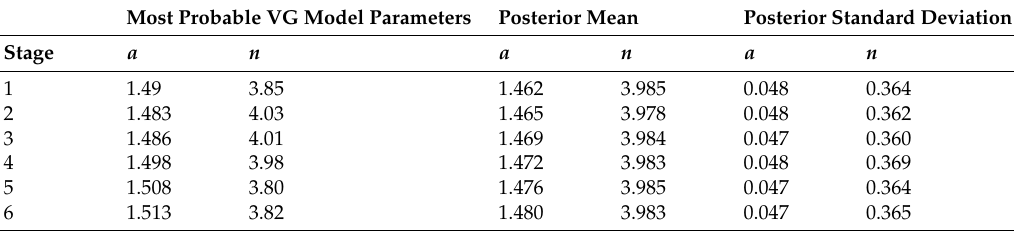
Figure 13. The influence of the monitoring value at different time stages on the update result: ( a ) parameter a ; ( b ) parameter n . Table 4. Impacts of different stages on update